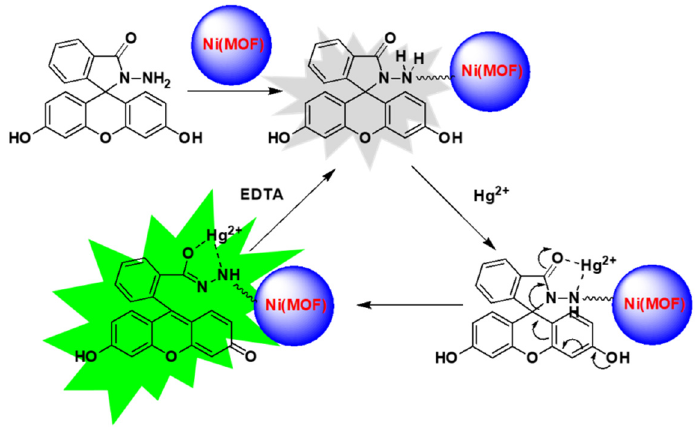
Figure 7. Changes in fluorescence emission spectra of FH@Ni(MOF) with the incremental addition of Hg 2+ (10 − 2 M) in water ( λ ex = 460 nm). Inset: fluorogenic changes in FH@Ni(MOF) upon the addition of Hg 2+ in water upon illumination at 365 nm.